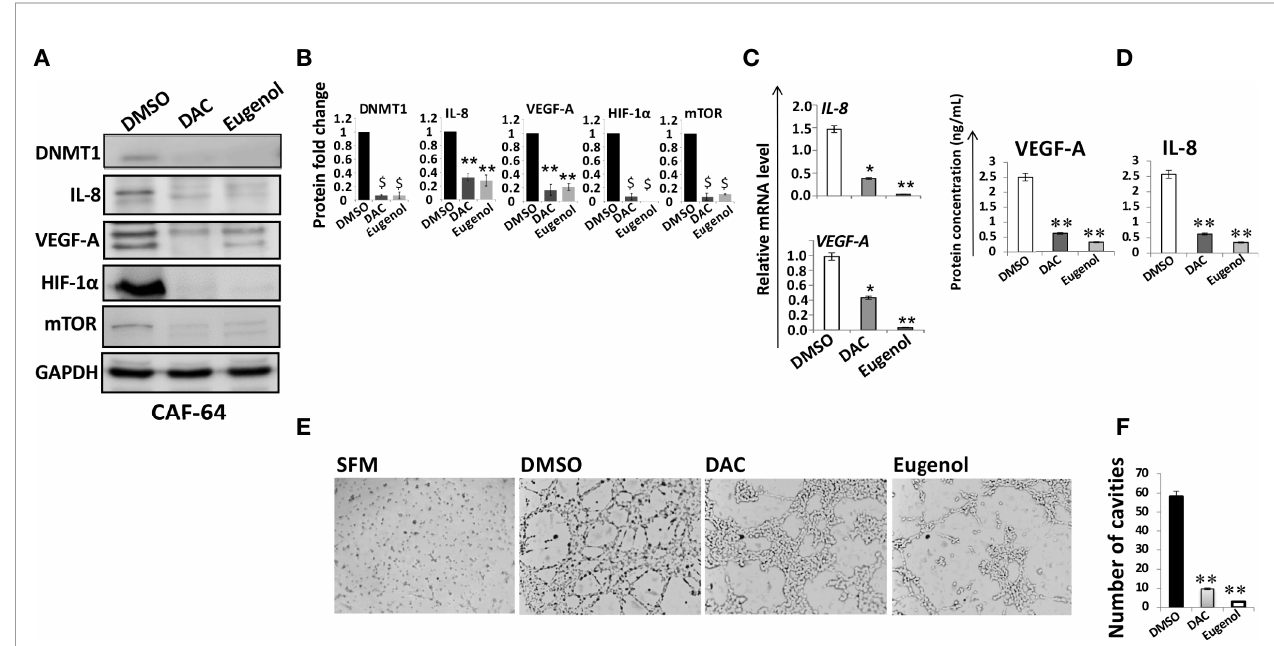
FIGURE 3 | Eugenol and DAC suppress the proangiogenic effects of breast myo fi broblasts by inhibiting DNMT1 expression. (A) CAF-64 cells were treated with the indicated concentrations of DAC and eugenol while DMSO was used as control, and then whole-cell lysates were prepared and utilized for immunoblotting analysis using speci fi c antibodies against the indicated proteins. The numbers under the bands represent fold changes relative to the control (DMSO) after normalization against the internal control GAPDH. (B) The histograms show the averaged protein level fold changes relative to the control after normalization against the internal control GAPDH. Error bars represent mean ± S.D (n=3). ** P<0.01 and $ P<0.001. (C) Total RNA was extracted from CAF-64 cells treated as shown, and the mRNA levels of the indicated genes were assessed using qRT – PCR. Error bars represent mean± S.D (n=3).* P ≤ 0.05, ** P ≤ 0.01 (D) CAF-64 cells were treated as indicated in SFM for 24 h, and then SFCM were collected, and the levels of the indicated proteins were determined by ELISA. Error bars indicate mean ± S.D (n=3). ** P ≤ 0.01. (E) HUVEC cells previously plated on matrigel (96-well plate) were treated with SFCM collected as described in (D) , while SFM was used as negative control, and then cells were incubated at 37°C for 8 hr. (F) Histogram shows the average number of formed cavities. Error bars represent means ± S.D (n=3). ** P ≤